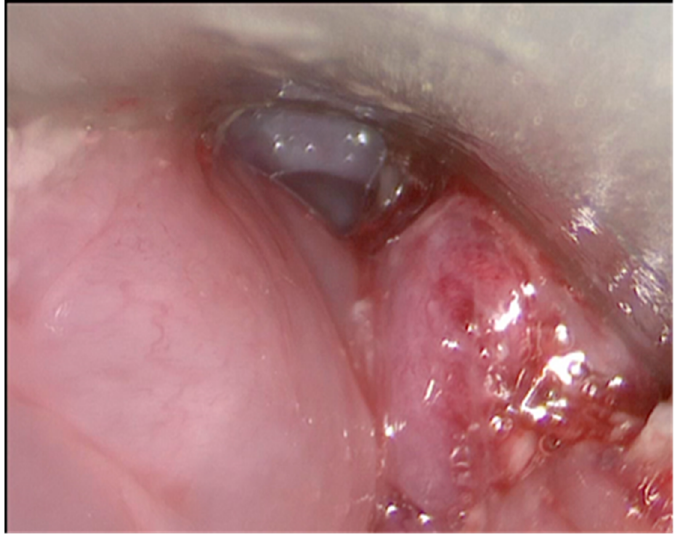
Figure 5. Endoscopy immediately performed after the surgery in the third recipient animal confirmed the correct revascularisation of the transplant .